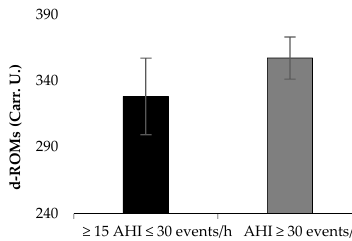
Figure 2. Oxidative stress marker on reactive oxygen metabolites’ levels (d-ROM) between groups.